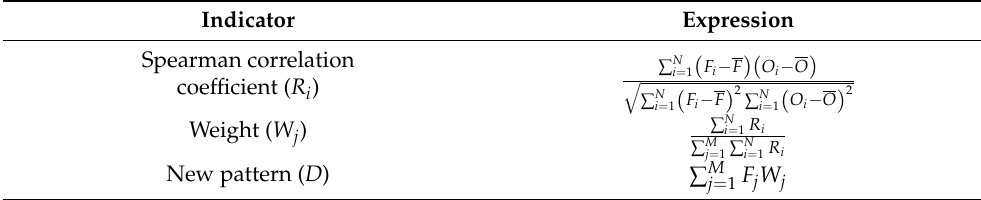
Table 3. Indicators used in WPM. The sorted observations and ensemble member precipitation are denoted as O and F , respectively. The i and j denote the i th day and j th ensemble member, respectively. M and N represent the number of ensemble members and the number of valid samples, respectively.